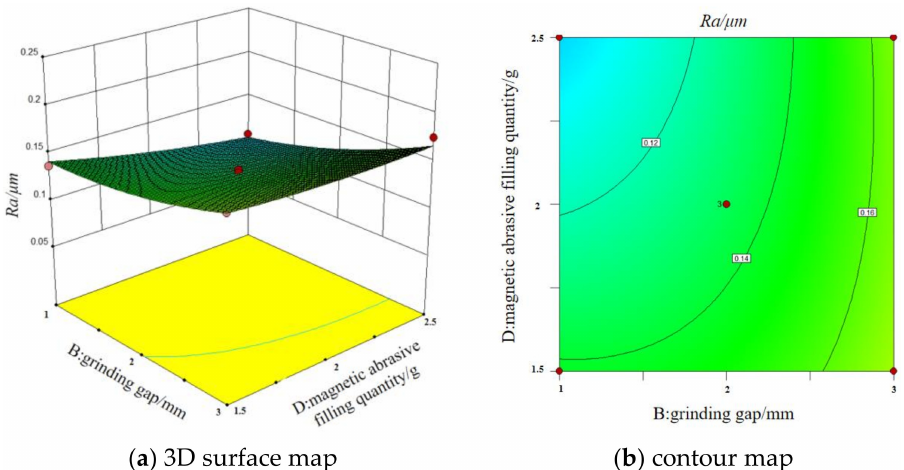
Figure 11. 3D surface map and contour map of the interaction between grinding gap and magnetic abrasive filling quantity on surface roughness.